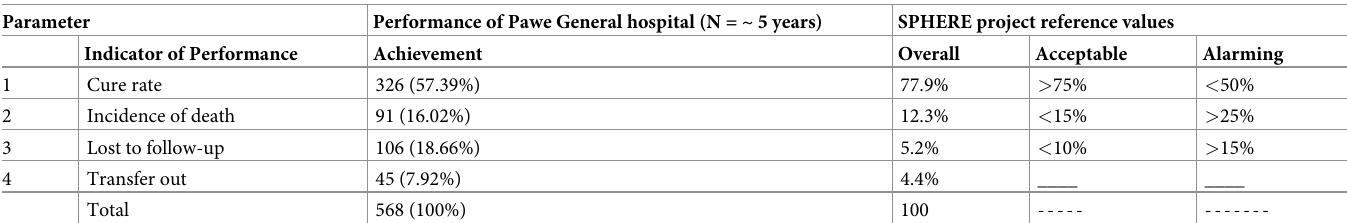
Table 3. Performance indicators achieved at Pawe general and referral hospital from 2015–2019 compared to the national Sphere reference standards (N = 568). Parameter